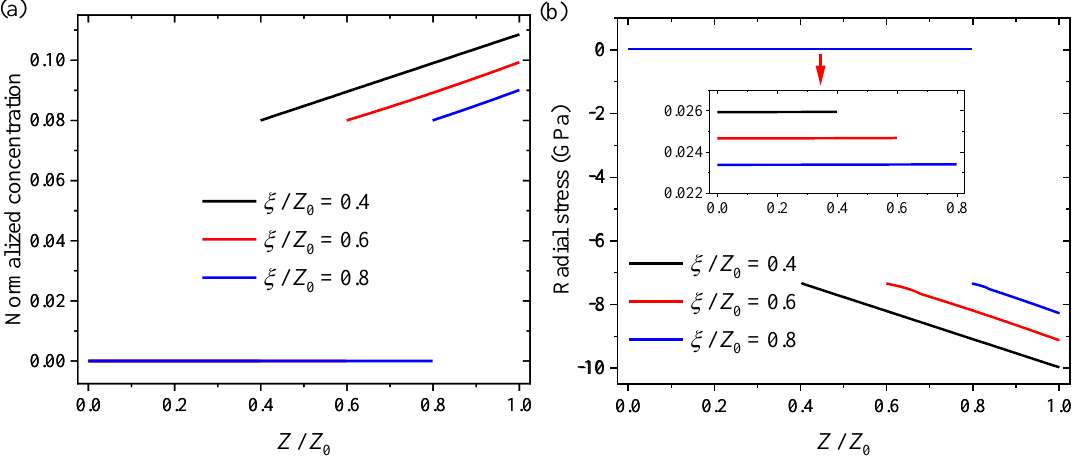
Figure 8. Spatial variations of ( a ) normalized concentration, and ( b ) radial stress along the thickness direction at the axisymmetric axis for different positions of the interface at stage I. (Total C-rate: 1/14 C).